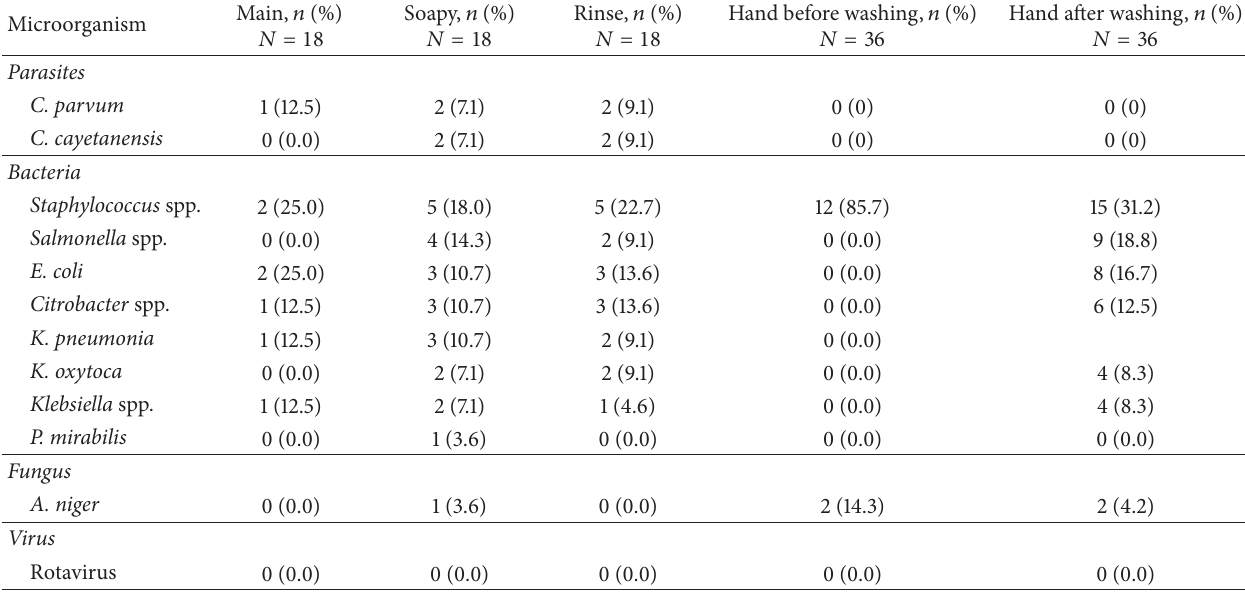
Table 2: Microbial contamination of different sources of bowl water and hands of children. Microorganism